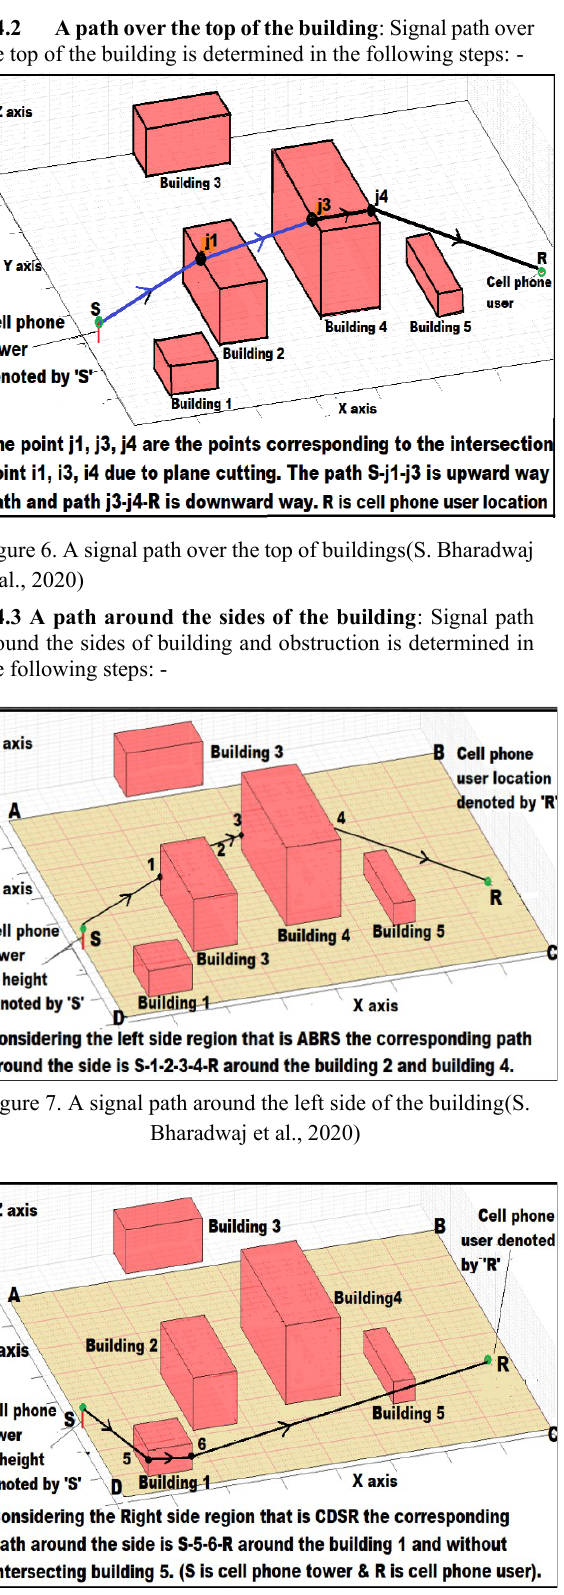
Figure 8. A signal path around the right side of the building(S.